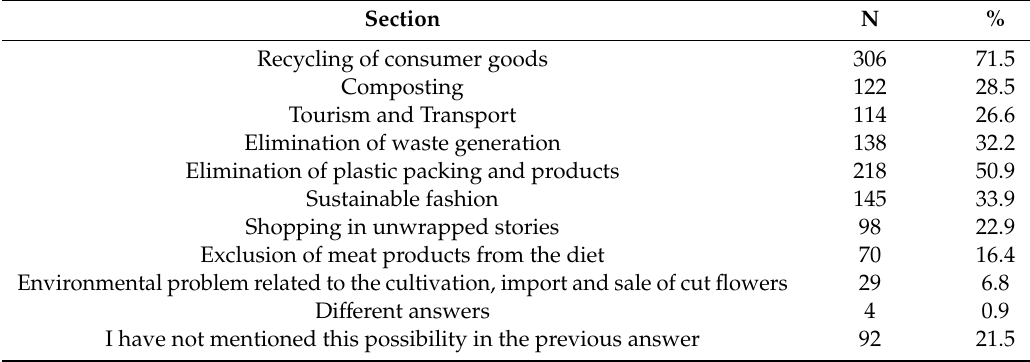
Table 2. Respondents’ spheres of interest.